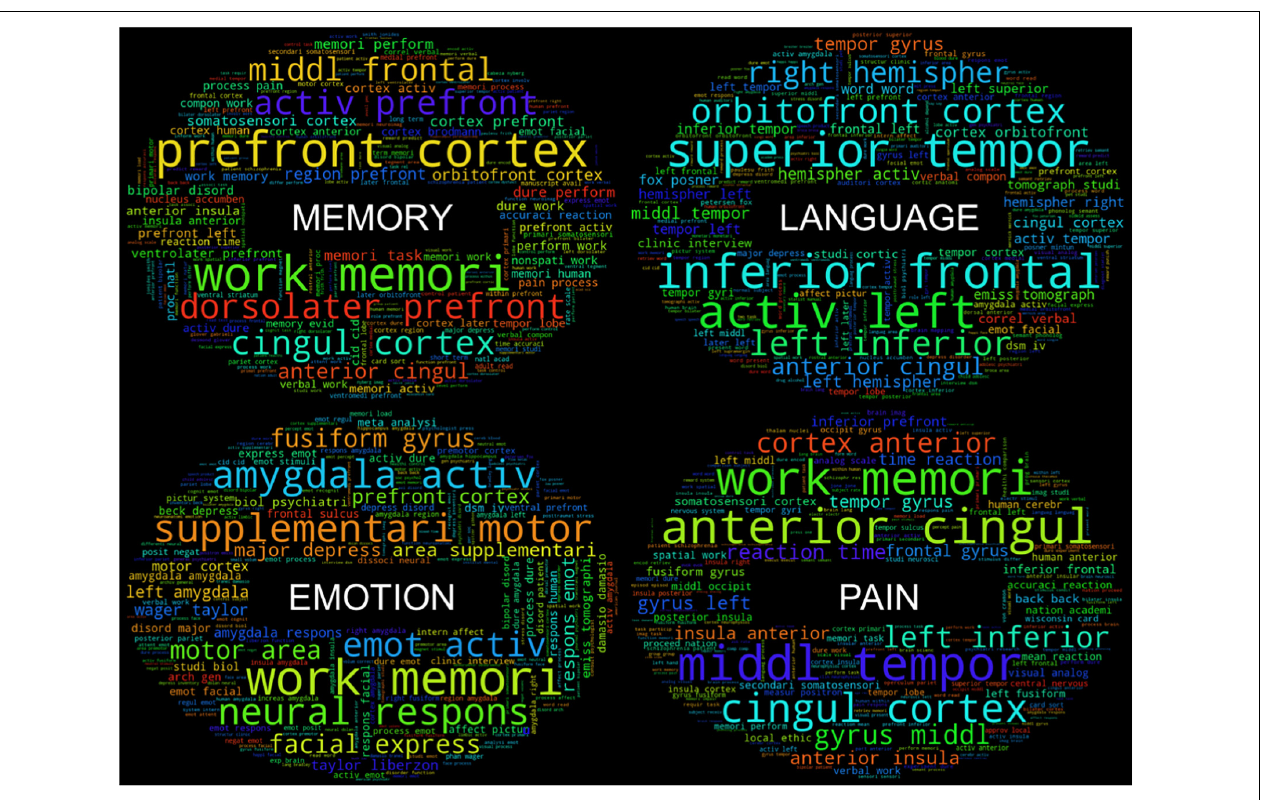
FIGURE 4 | Feature “word clouds” from cluster subsets. “Word clouds” for the four subsets of clusters were generated by utilizing the top 10% of the most frequently used bag-of-words features across labels in each subset. Larger words indicate a larger representation of feature frequency within each